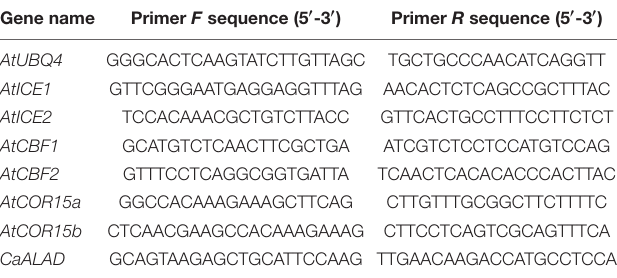
TABLE 2 | Oligonucleotide primers used for qRT-PCR assays in this